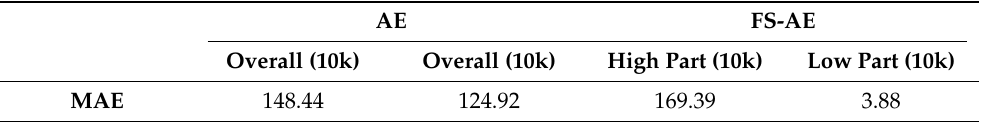
Figure 6. The profile of sample data for the feasibility test. Table 4. The evaluation of the proposed method applied to the vanilla AE model.